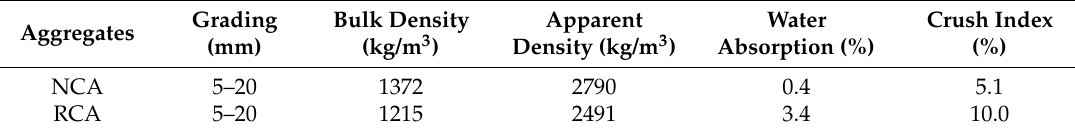
Table 1. Physical properties of coarse